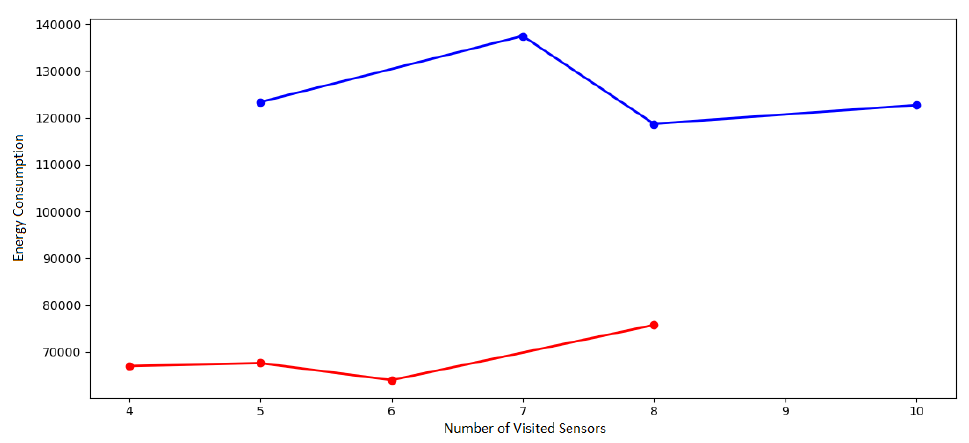
Figure 6. Comparison between the model with a single vehicle and multi vehicles. Model